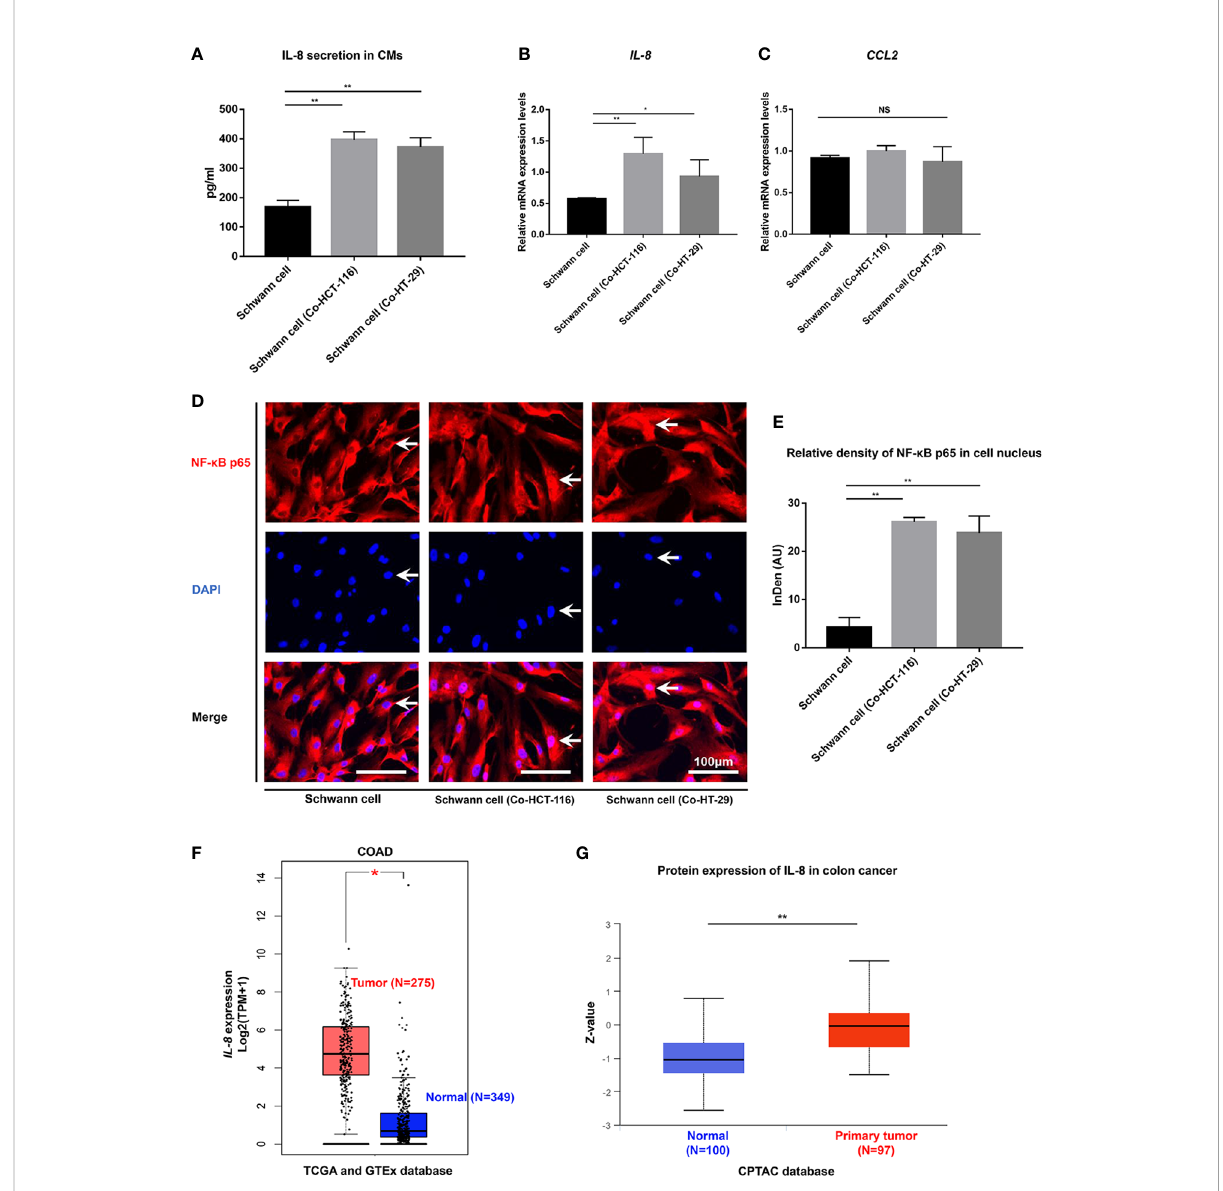
FIGURE 3 NF- k B/IL-8 signaling pathway is activated in SCs in the TME. (A) ELISA results showed the secretions of IL-8 from SCs were enhanced after co- cultivation with HCT-116 and HT-29 cells. Gene expression of IL-8 (B) and CCL2 (C) were detected using RT-qPCR in SCs and SCs after co- cultivation with HCT-116 and HT-29 cells. (D) Immuno fl uorescent staining results (scale bar, 100 µm) indicated the nuclear translocation of NF- k B in SCs after co-cultivation with HCT-116 and HT-29 cells. The arrows showed the nuclear expression of NF- k B p65 proteins. (E) Integrated density of NF- k B p65 in cell nucleus quanti fi ed in each group. (F) The gene expression levels of IL-8 in COAD in the TCGA project, the corresponding normal tissues of the GTEx database were included as controls. The box plot data were supplied. (G) The expression level of IL-8 total protein between normal tissue and primary tissue of colon cancer based on the CPTAC dataset. **P<0.01 *P<0.05. AU, arbitrary units; CM, conditioned medium; COAD, colon adenocarcinoma; CPTAC, clinical proteomic tumor analysis consortium; DAPI, 4, ’ 6-diamidino-2- phenylindole, dihydrochloride; GTEx, genotype-tissue expression; IL-8, interleukin 8; NF- k B, nuclear factor kappa B; NS, not signi fi cant; SC, Schwann cell; TCGA, the cancer genome